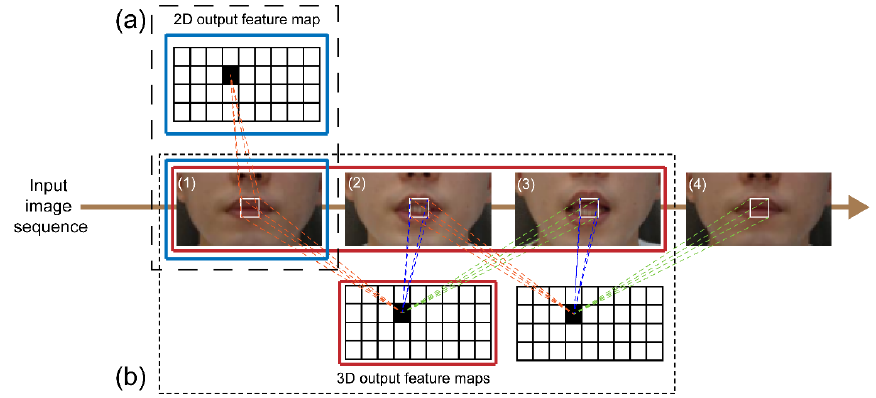
Figure 4. Comparison of convolutions in ( a ) 2D; ( b ) 3D.